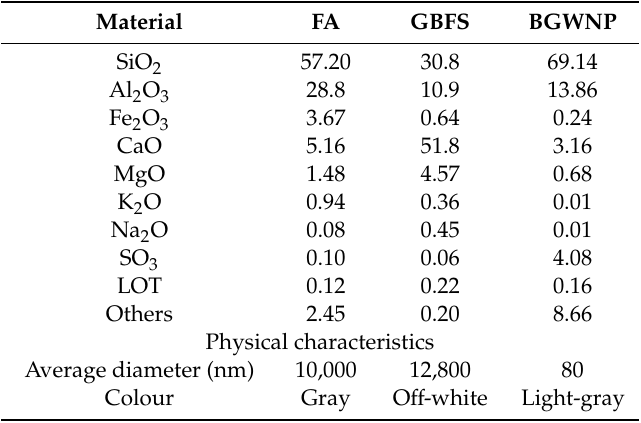
Table 2. Chemical and physical properties of FA, GBFS and